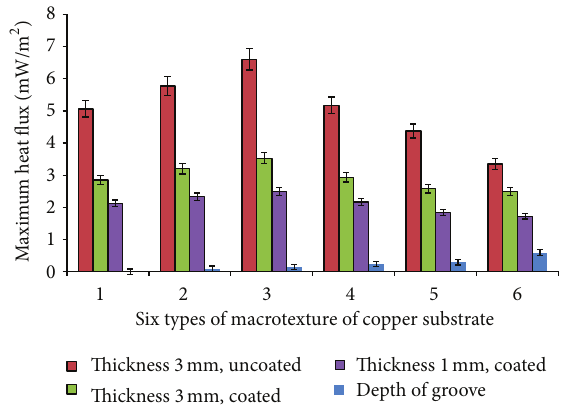
Figure 5: Heat flux versus strip thickness and substrate textures.